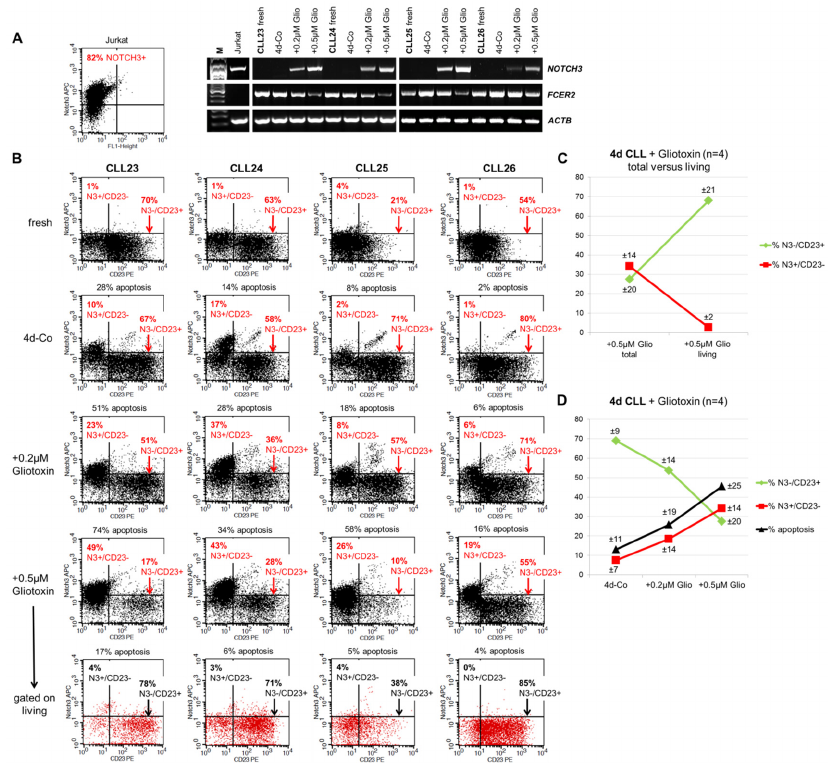
Figure 4. NOTCH3 and CD23 surface expression are mutually exclusive on CLL cells. ( A ) RT-PCR and ( B ) FACS showing NOTCH3 and FCER2 (CD23) expression in freshly isolated CLL cells and after 4 days in culture in relation to surface CD23 expression and spontaneous as well as gliotoxin-induced apoptosis. The T-ALL cell line Jurkat served as positive control for NOTCH3 mRNA and NOTCH3 surface expression. ( C ) Gating on the remaining living cells after gliotoxin treatment according to their forward / side scatter properties revealed that living CLL cells were enriched for NOTCH3- / CD23 + cells. ( D ) Summary of the FACS data, demonstrating a direct correlation of the percentage of NOTCH3 +/ CD23- and apoptotic CLL cells and an indirect correlation of these two parameters with the percentage of NOTCH3- / CD23 + CLL cells. Data presented as means ( ±